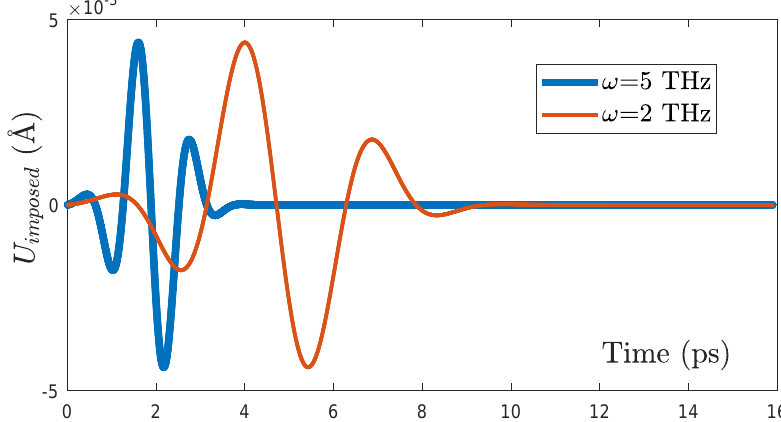
Figure 4. Wave packet imposed as the displacement of the left side of the sample, for two different frequencies: 2 THz, 5 THz